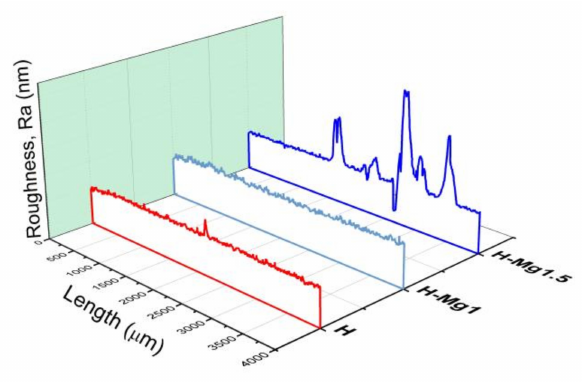
Figure 6. Representative profiles of the obtained coatings.